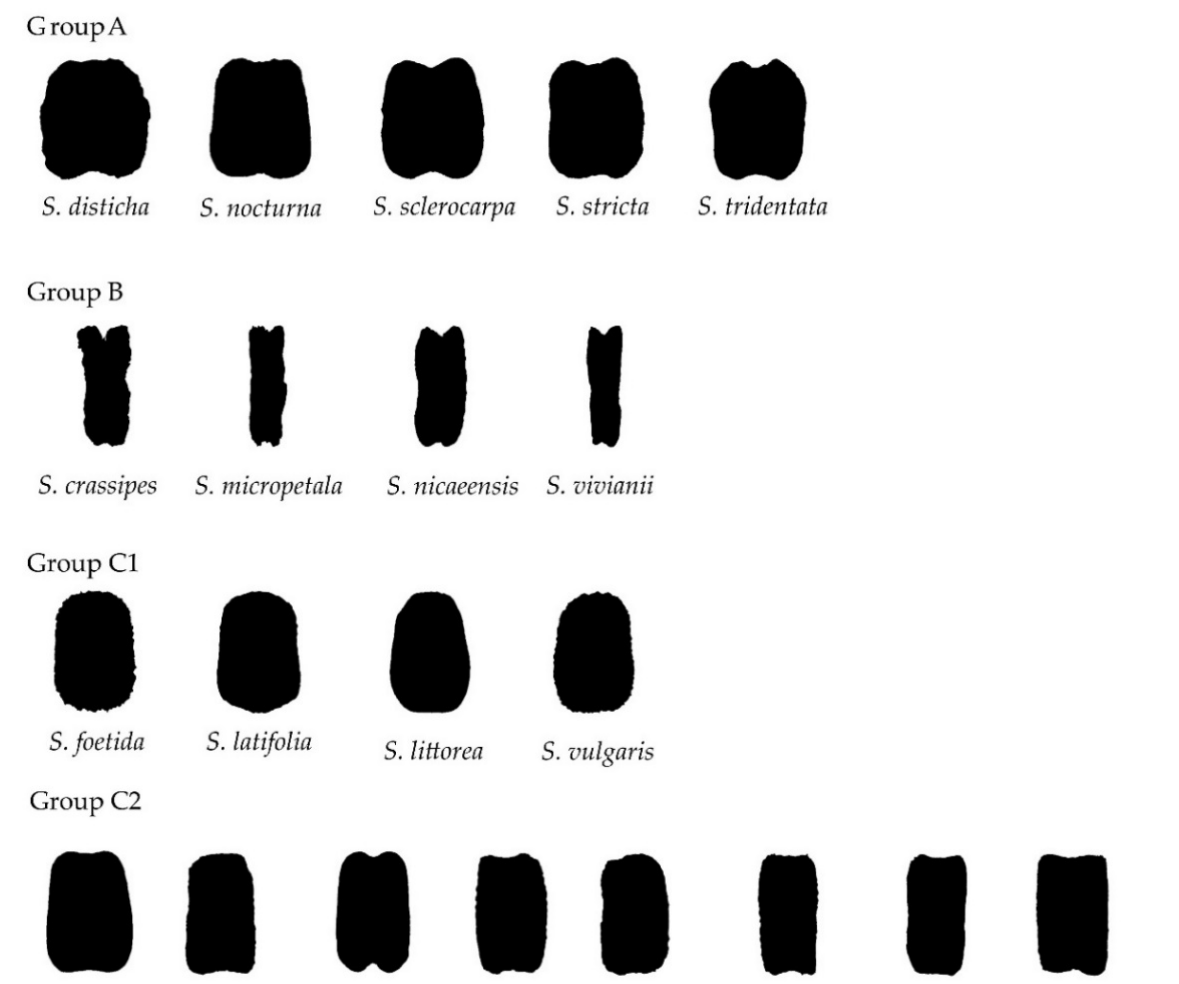
Figure 3. Average silhouettes obtained for the dorsal views of the seed in the 21 species of Silene analyzed. Groups A, B and C are different in their roundness and aspect ratio. The silhouettes in subgroup C1 are convex, while the silhouettes in C2 are concave.